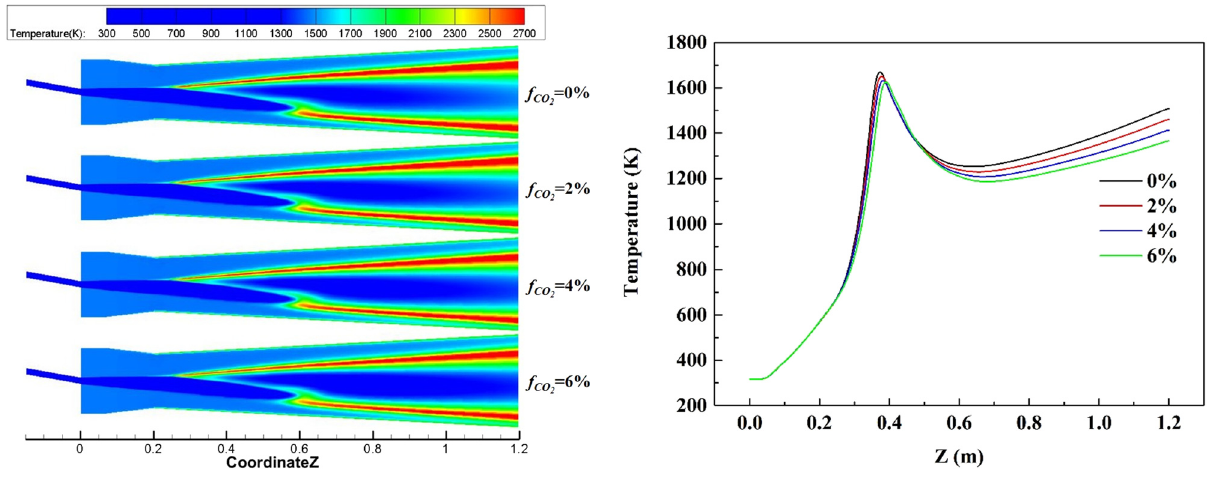
Figure 7: The temperature curve on the axis of the furnace under di ff erent f in the hot CO 2